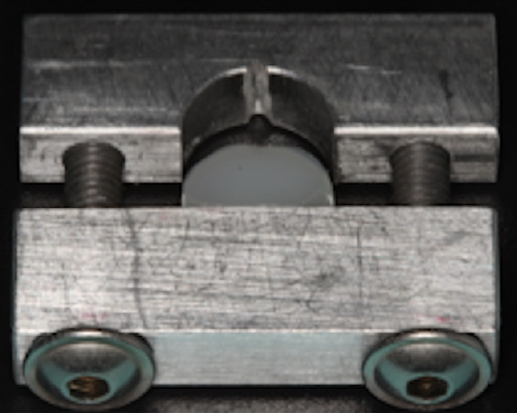
Figure 1. Semicircular metal molds with a diameter of 10 mm and a depth of 6 mm used in this study.